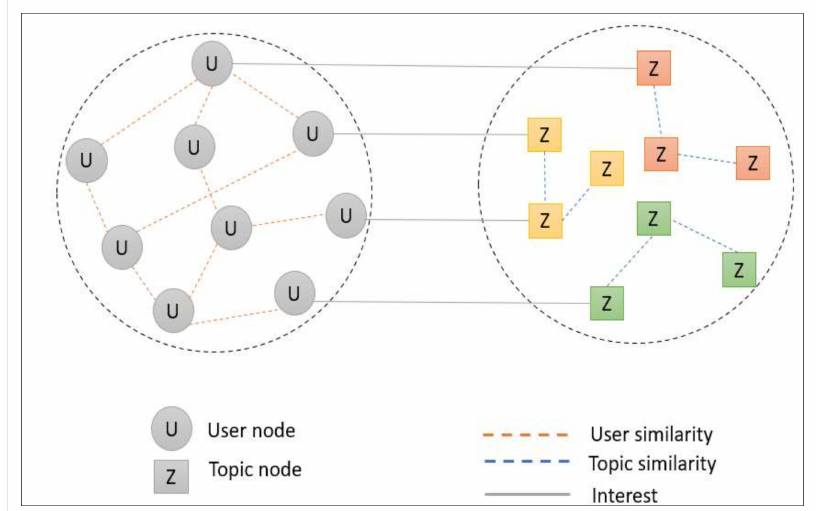
Figure 6. The Proposed Schema of Heterogeneous Graph.